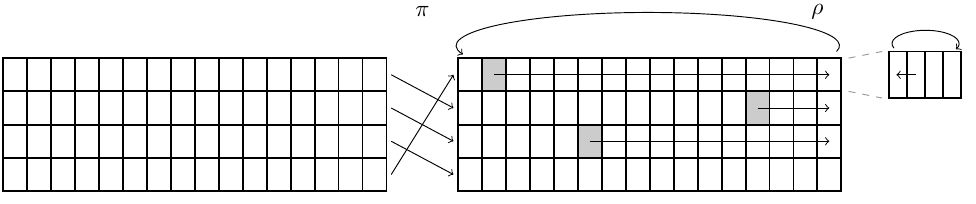
Figure 3: The transposition layer ρ ◦ π